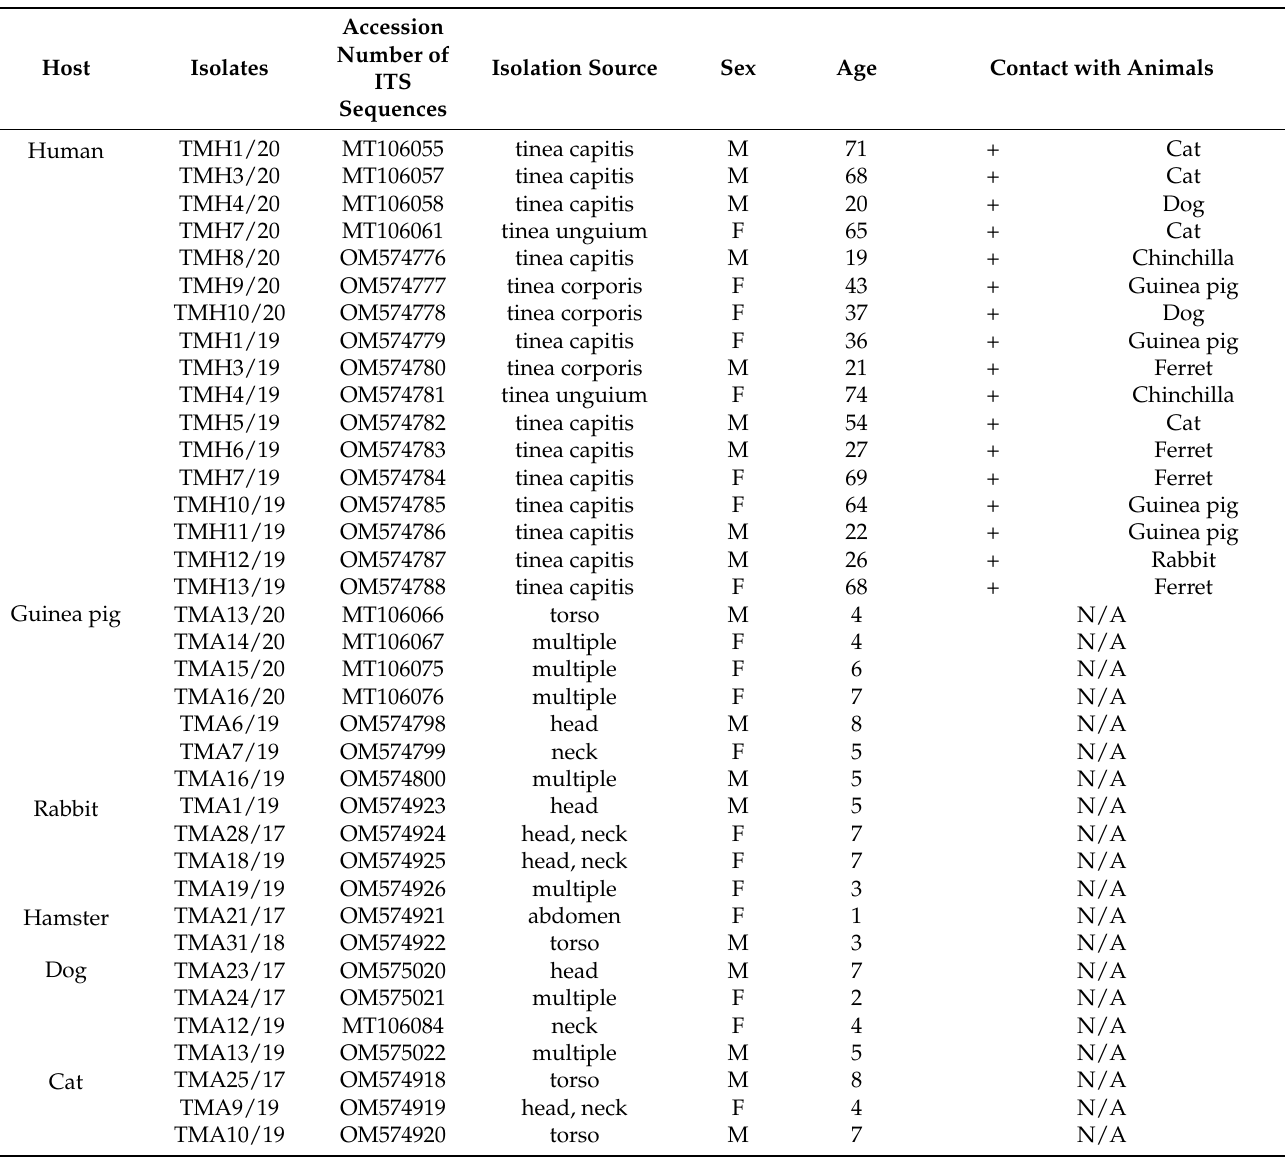
Table 1. The clinical characteristics of Trichophyton mentagrophytes strains of human and animal